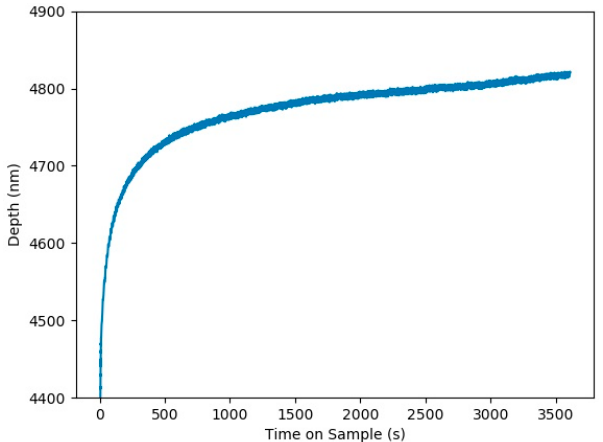
Figure 4. Plot of the variation of indentation depth with time in a 3600-s creep test. At the beginning of the hold, the displacement rate is larger because the stress on the sample is higher. As the contact area increases due to creep of the sample, the stress and thus the displacement rate decreases. Towards the end of the test, the apparent acceleration in the creep rate (the increase in slope of the curve) is caused by thermal drift of the